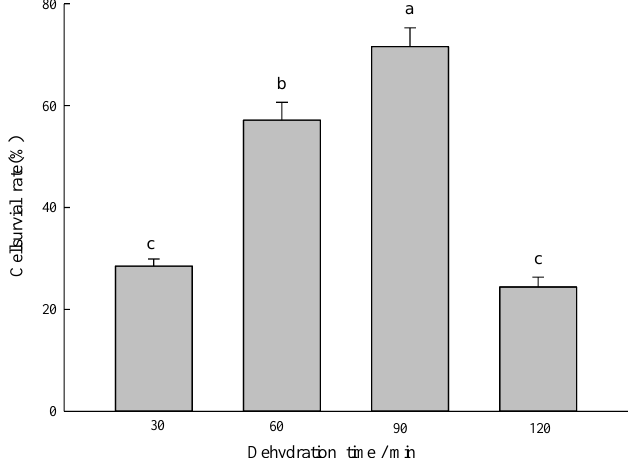
Figure 5. Effect of cryoprotection time on the cell survival percentage of F. mandshurica embryonic callus after cryopreservation by the slow cooling method. Note: Lowercase letters represent significant differences at p < 0.05.